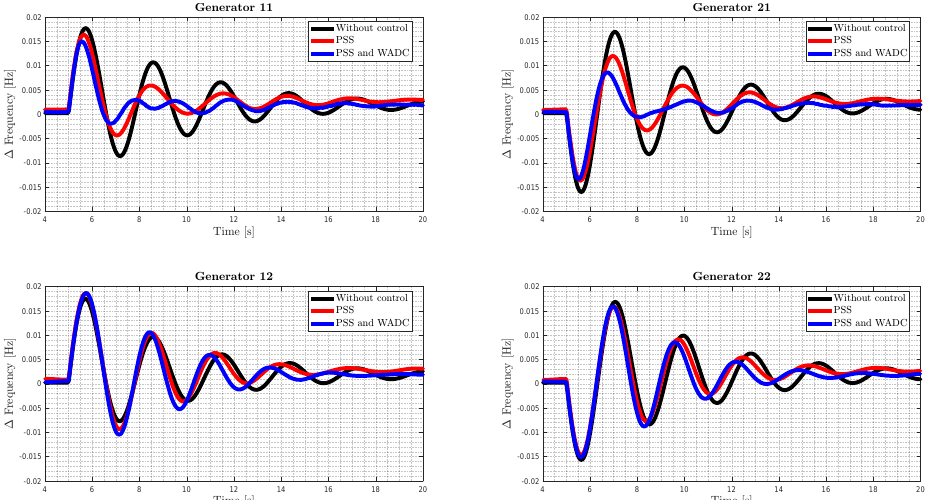
Figure 14. Comparison of the frequency deviations in the CHIL setup of the three cases (without control, PSS only, PSS and WADC) after applying the same